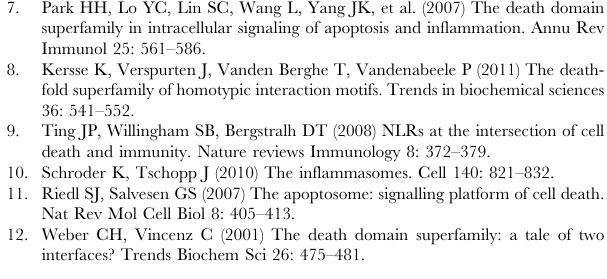
Figure S1 Control gels for GST-pull down experiments.